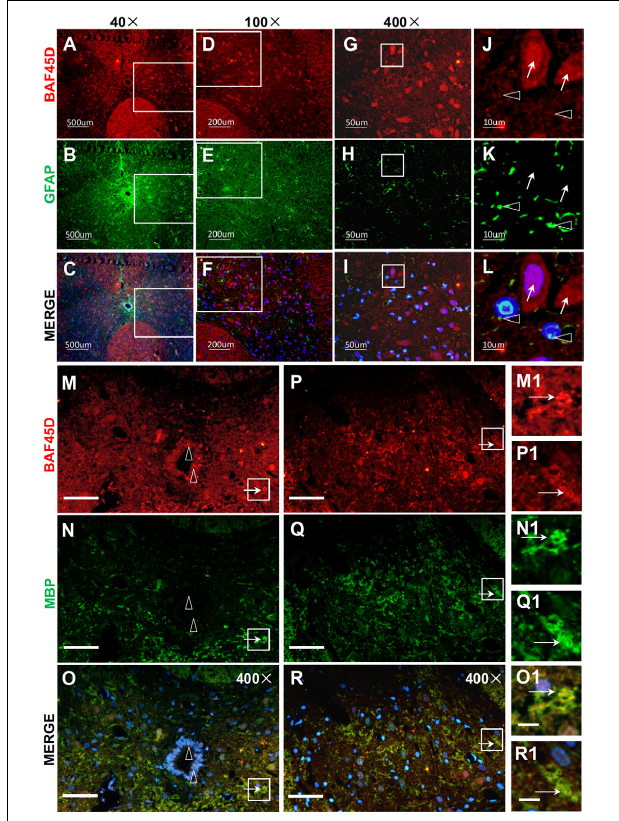
FIGURE 3 | BAF45D was expressed in oligodendrocytes but not astrocytes in intact adult rat spinal cords. (A–L) Immunofluorescence assays were performed on histological sections prepared from intact adult rat spinal cords using anti-BAF45D and anti-GFAP antibodies (A–C) . (D–F) Represent 100 × magnification of the insets shown in (A–C) , respectively. (G–I) Represent 400 × magnification of the insets shown in (D–F) . (J–L) Represent 2000 × magnification of the insets shown in (G–I) . BAF45D immune-positive cells are indicated by arrows while GFAP immune-positive cells are indicated by triangles. Scale bars: 500 µ m (A–C) , 200 µ m (D–F) , 50 µ m (G–I) , and 10 µ m (J–L) . (M–R) Immunofluorescence assays, using anti-BAF45D and anti-MBP antibodies, were performed on histological sections showing CC areas (M–O) and non-CC areas (P–R) in intact spinal cords from adult rats. (M1–O1) Represent 1200 × magnification of the insets shown in (M–O) . (P1–R1) Represent 1200 × magnification of the insets shown in (P–R) . Triangles indicate BAF45D-positive SCECs (M–O) while arrows indicate the colocalization of BAF45D with MBP (M1–R1) . Scale bars: 50 µ m (M–R) and 10 µ m (O1,R1)